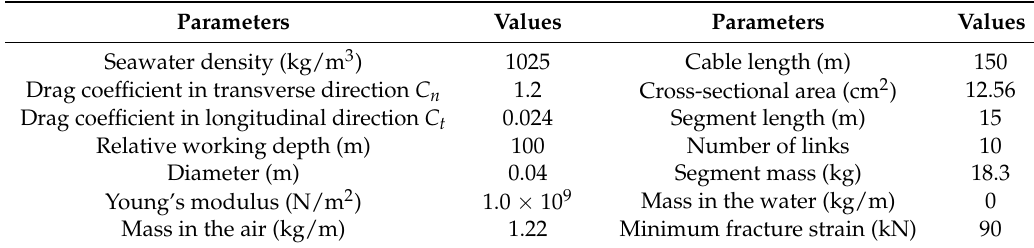
Table 2. Parameters of the lumped parameter method